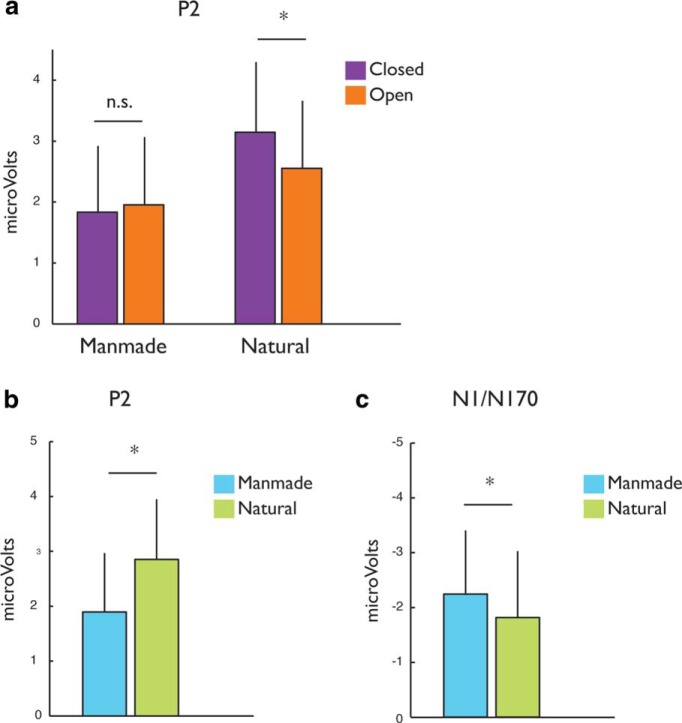
Grand average ERP analysis results for Experiment 2. a, Mean P2 peak amplitudes in response to open and closed scenes (orange and purple, respectively) presented separately for the man-made and natural scenes (left and right columns respectively). b, Mean P2 peak amplitudes in response to natural (green) and man-made scenes (cyan). c, Mean N1 peak amplitudes in response to natural (green) and man-made scenes (cyan). All data are plotted for the posterior lateral sites. Significant differences (p < 0.05) between pairs of categories are denoted by asterisk (error bars indicate between-subjects SE).